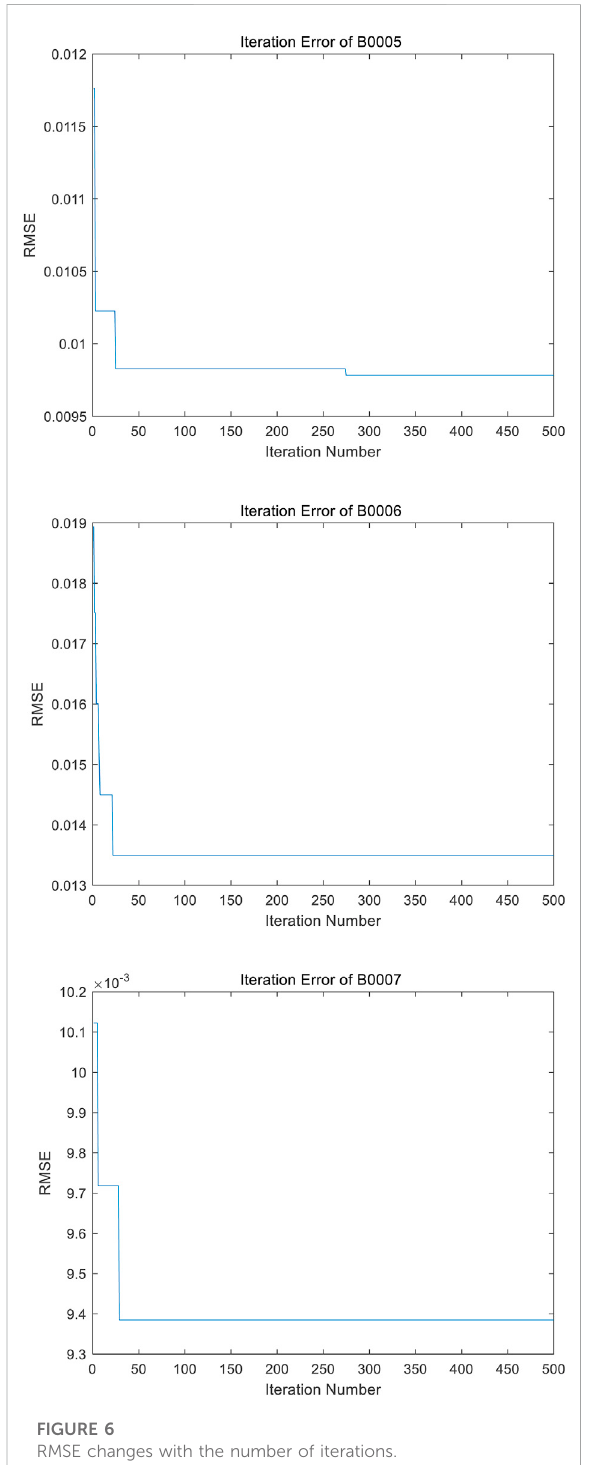
FIGURE 6 RMSE changes with the number of iterations.